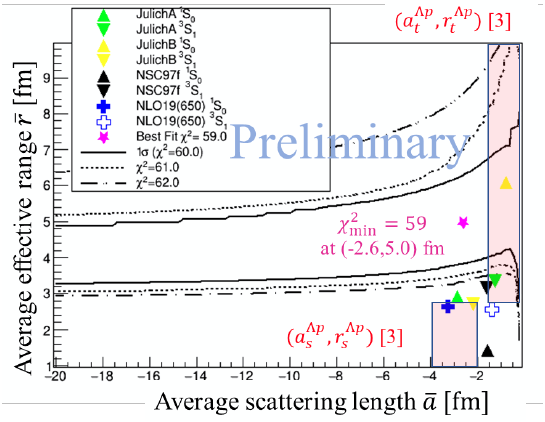
Figure 4. The χ 2 distribution depending on an average scattering length (¯ a ) and e ff ective range (¯ r ). The average values are assumed to be same value of spin singlet and triplet. The χ 2 has minimum value at ( − 2 . 6 , 5 . 0) fm (star marker in pink). The colored markers show the potential value in each Λ n potential model. The hatched boxes in red show a experimental result of the Λ p FSI in the singlet and triplet, respectively [3]. The black lines show the contour lines at χ 2 = 60 , 61 ,